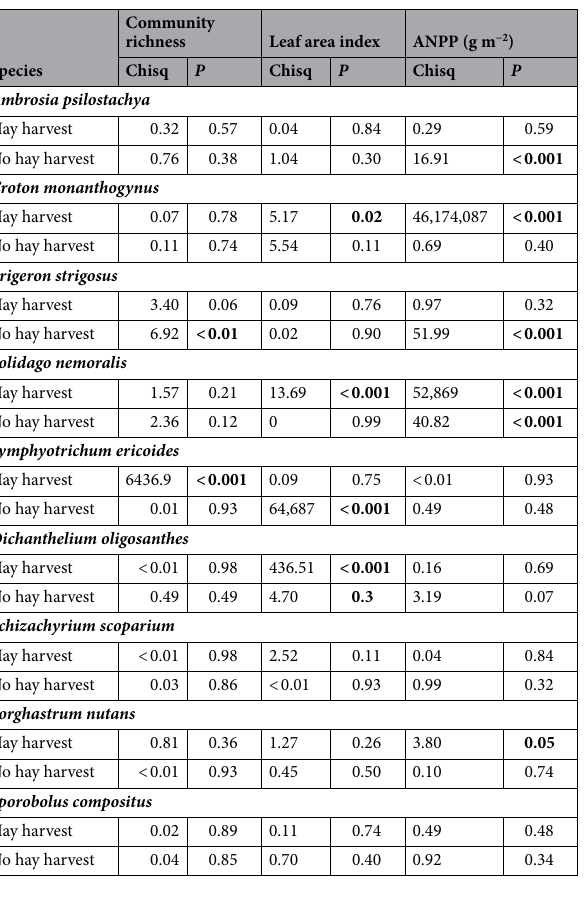
Table 2. GLMM of main effects of plant richness, leaf area index and ANPP on focal species cover , under hay harvest vs. no hay harvest across the precipitation gradient. Significant P (≤ 0.05) shown in